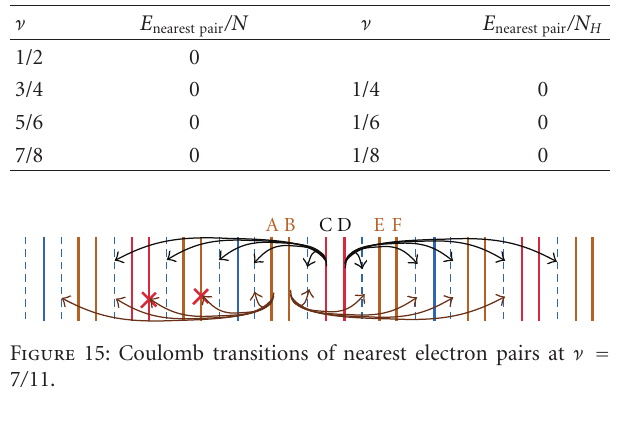
Table 3: Nearest pair energies at ν = (2 j − 1) / (2 j ) and ν = 1 / (2 j ).